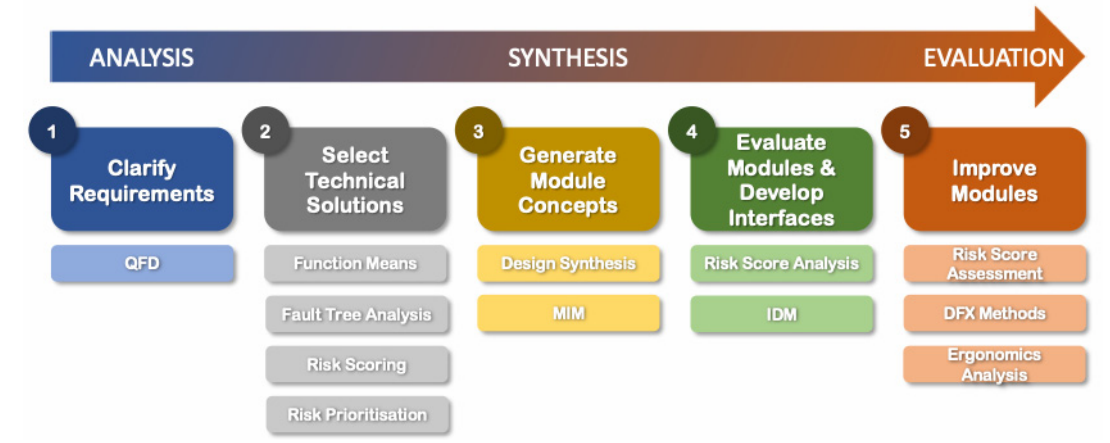
Figure 3. Safety embedded MFD